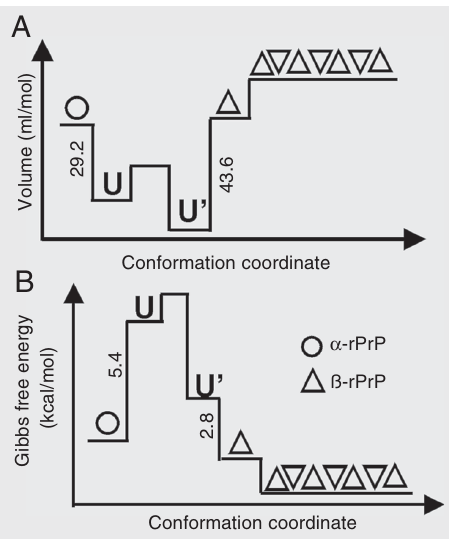
Figure 1. α -rPrP and ß-rPrP dis- play different stabilities against pressure. The transition values as a function of pressure were obtained from the native α -rPrP α -helical secondary structure and from ß-sheet changes for ß- rPrP (obtained from Ref. 30). The extent of denaturation ( f ) was calculated as follows: f = (IR obs - IR initial /IR final - IR initial ), where IR obs is the observed IR intensity value at pressure p, IR initial is the IR value at 0.1 MPa, and IR final is the final IR intensity value of the pressure- induced unfolding curve (from Ref. 30). coordinateFigure 2. Volume (A) and Gibbs free-energy (B) diagrams of α - rPrP and ß-rPrP. α -rPrP (circle) and ß-rPrP (triangle) pressure- denatured states are denoted U and U’, respectively. The num- bers indicate volume (ml/mol) (A) and Gibbs free-energy of un- folding (kcal/mol) (B) determined for α -rPrP and ß-rPrP pressure- induced unfolding (from Ref.